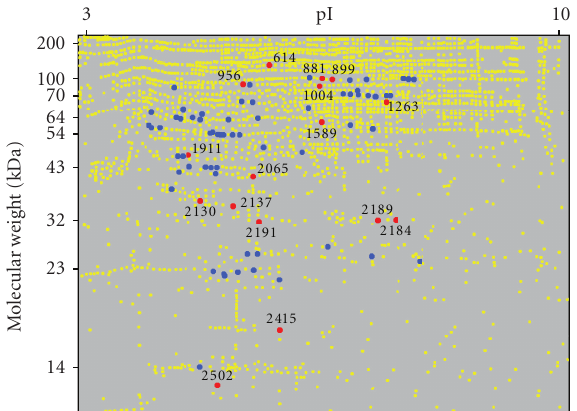
Figure 1: The spatial distribution of proteins spots (yellow dots) detected in human plasma by 2-D DIGE. Identified proteins (blue dots) and those showing di ff erences between the theoretical and observed molecular weights (numbered red dots) are